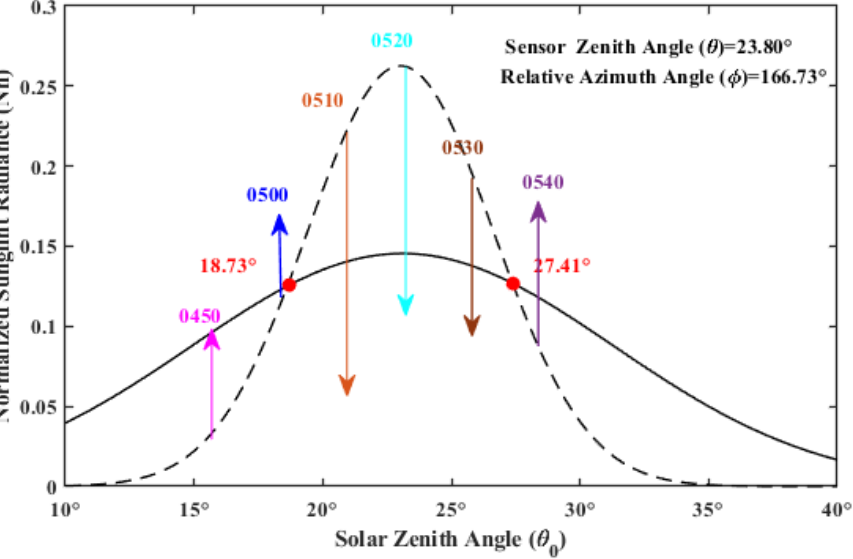
Figure 13. Curves of the normalized sunglint radiance ( N n ) with the solar zenith angle ( θ 0 ), where the sensor zenith angle ( θ ) remains fixed at 23.8 ◦ and the relative azimuth angle ( φ ) remains fixed at 166.73 ◦ . The roughness variance ( σ 2 ) values of the sea surface and leading wave are 0.003 and 0.01324, respectively. There are two intersection points in the curves, i.e., the solar viewing angle ( θ 0c ). The pink arrow indicates that the solar zenith angle ( θ 0 ) of the leading wave is 16.22 ◦ at 04:50 UTC, the blue arrow indicates that the solar zenith angle ( θ 0 ) of the leading wave is 18.71 ◦ at 05:00 UTC, the orange arrow indicates that the solar zenith angle ( θ 0 ) the leading wave is 21.21 ◦ at 05:10 UTC, the cyan arrow indicates that the solar zenith angle ( θ 0 ) of the leading wave is 23.70 ◦ at 05:20 UTC, the brown arrow indicates that the solar zenith angle ( θ 0 ) of the leading wave is 26.19 ◦ at 05:30 UTC, and the purple arrow indicates that the solar zenith angle ( θ 0 ) of the leading wave is 28.68 ◦ at 05:40